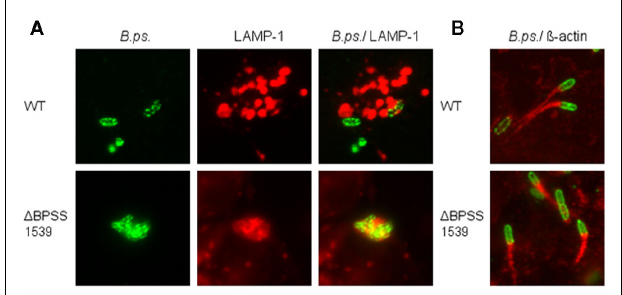
FIGURE 2 | Burkholderia pseudomallei is able to escape from the endocytotic vesicle and to form actin tails in hepatocytes. HepG2 cells were infected with either B. pseudomallei wild-type (WT) orT3SS-3 mutant Δ BPSS1539 using a MOI of ∼ 400:1 and analyzed by immunofluorescence microscopy (magnification × 1000). (A) Representative micrographs showing the association of intracellular B. pseudomallei with LAMP-1-containing vacuoles 8h after infection. Bacteria were stained green with mouse anti- B. pseudomallei EPS (3015 γ 2b) and Alexa Fluor 488 anti-mouse IgG2b antibodies. LAMP-1 was stained red with mouse anti-LAMP-1 γ 1 and Alexa Fluor 568 anti-mouse IgG1 antibodies. (B) Representative micrographs showing the formation of actin tails by B. pseudomallei 16h after infection. Bacteria were stained green with mouse anti- B. pseudomallei EPS (3015 γ 2b) and Alexa Fluor 488 anti-mouse IgG2b antibodies. Actin tails were stained red with rabbit anti- β -actin and Cy3-conjugated goat anti-rabbit IgG